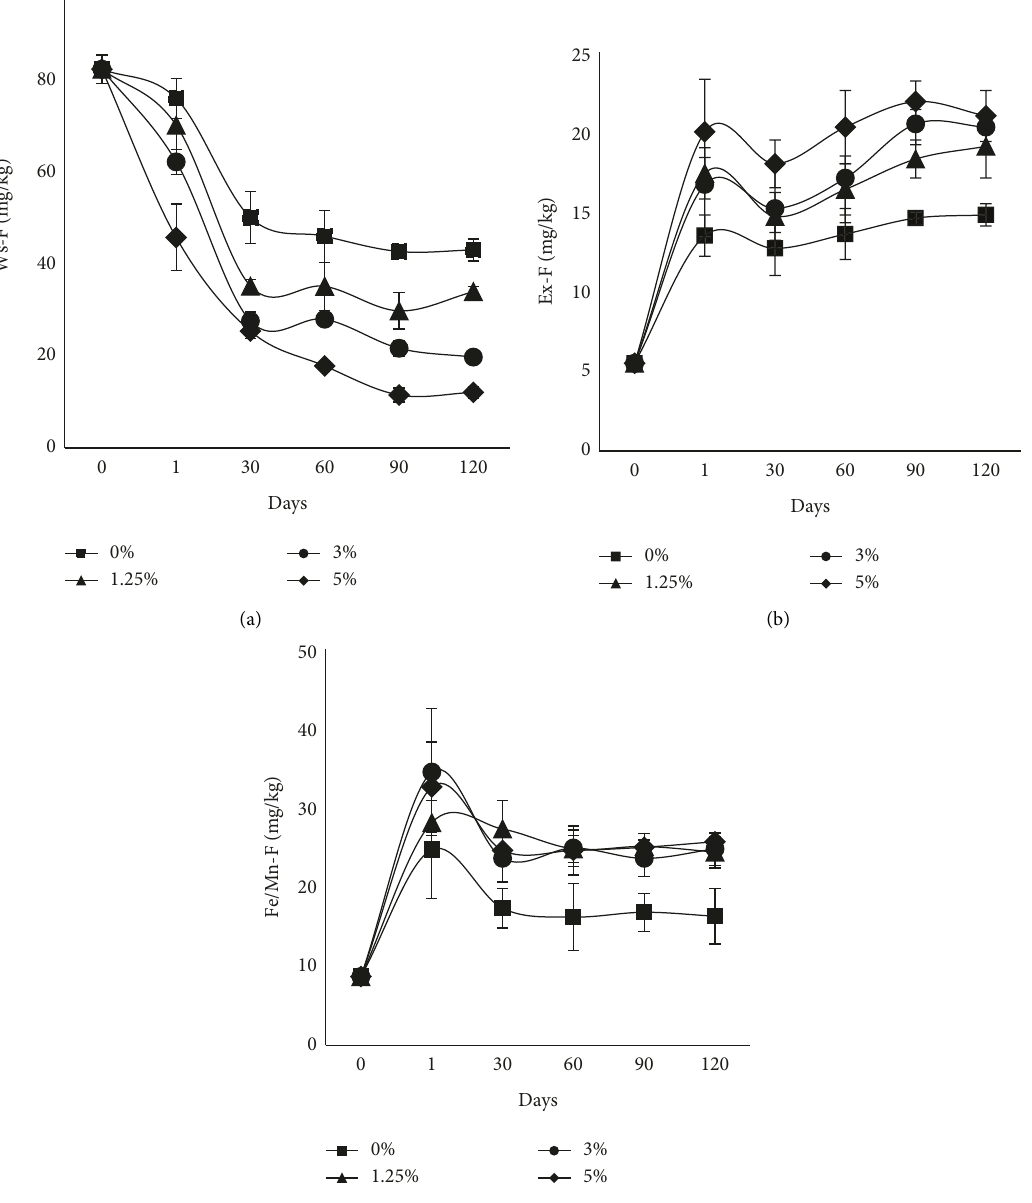
Figure 3: The impact of fermented seaweed (FSW) amendment on fluoride fractions of the soil (a) water soluble-fluoride (Ws-F), (b) exchangeable-fluoride (Ex-F), and (c) fluoride-bound to iron/manganese